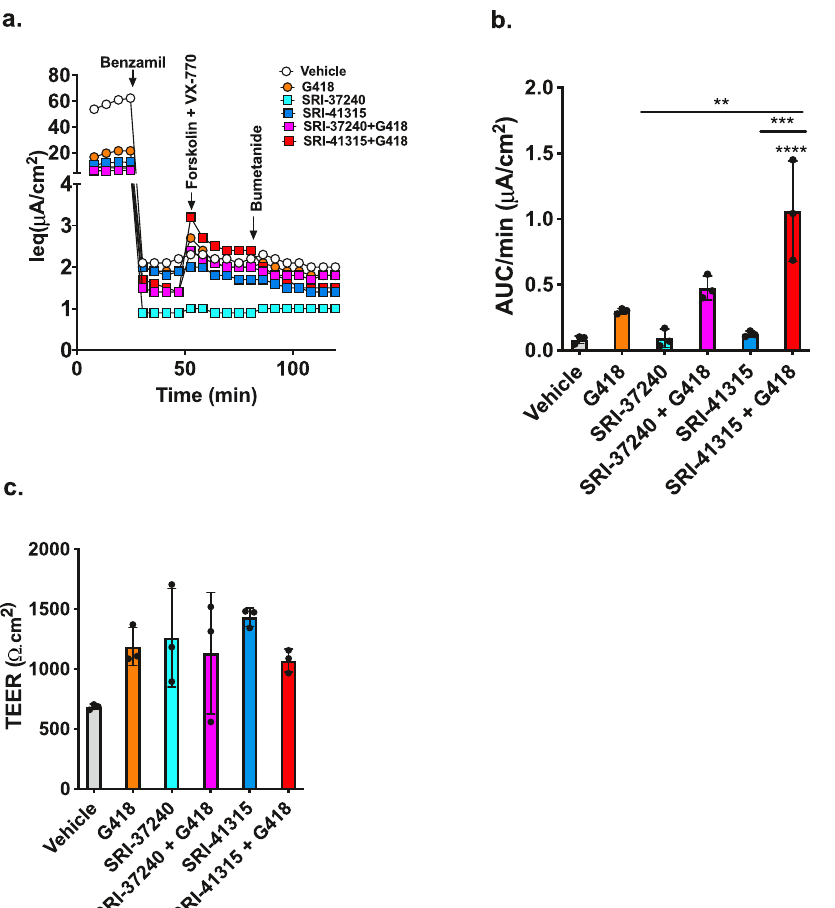
Fig. 7 CFTR function is restored by SRI-37240 and SRI-41315 in combination with G418 in primary bronchial epithelial cells derived from a CF patient with CFTR nonsense alleles. Primary HBE cells derived from a donor with an R553X/W1282X CFTR genotype were grown at an air – liquid interface until terminally differentiated and then treated with SRI-37240 (10 µ M) or SRI-41315 (5 µ M) alone or in combination with G418 (100 µ M) for 72 h and then CFTR function was the measured. a Representative I eq traces after acute treatments with benzamil (10 µ M), forskolin (10 µ M) + ivacaftor (1 µ M), and bumetanide (20 µ M). b Corresponding average current calculated from the area under the curve between forskolin/ivacaftor-induced CFTR activity onset and anion transport inhibition with bumetanide ( n = 3, data are expressed as mean ± S.D. and statistically analyzed using ordinary one-way